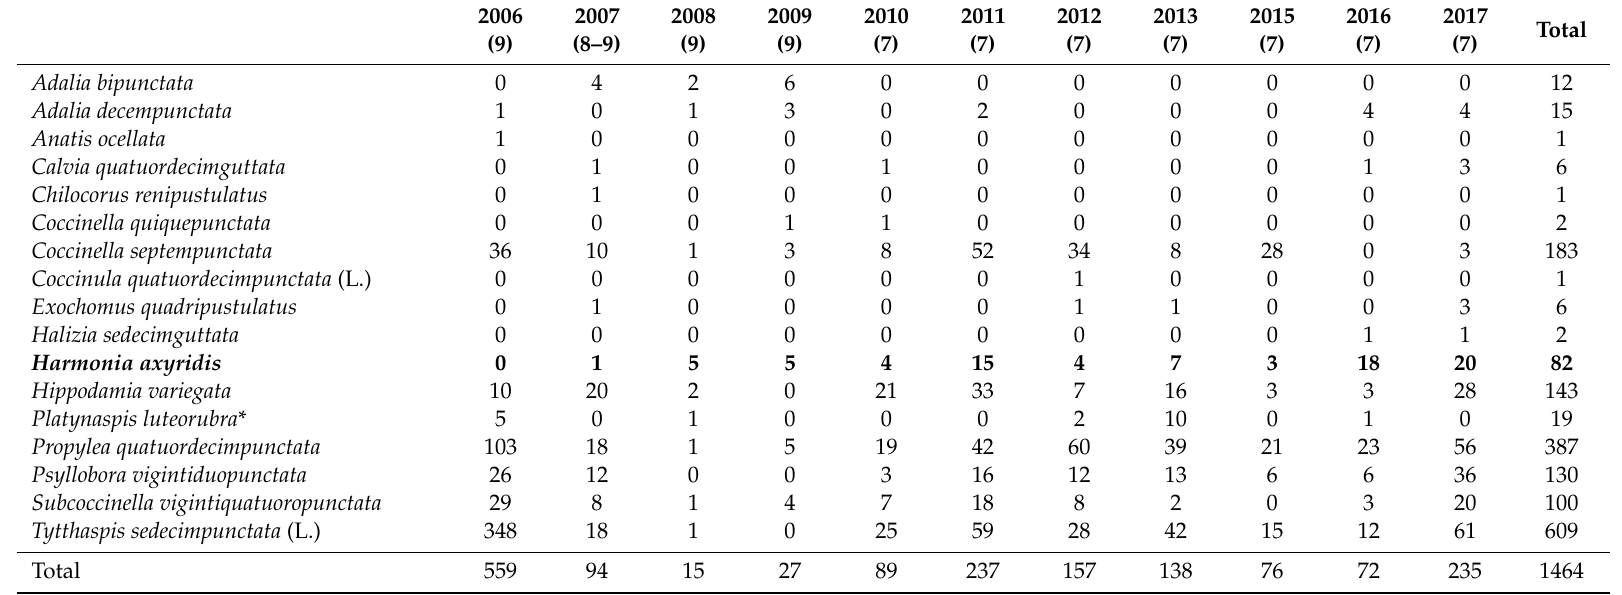
Table 2. Species and number of adult ladybirds collected in the 15 meadows from 2006 to 2017. Numbers between parentheses indicate the number of collections. Ladybirds were not sampled in